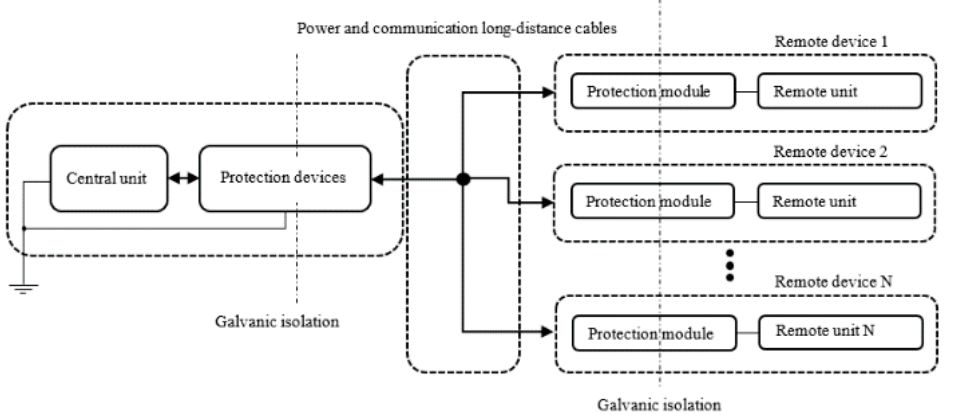
Figure 1. General diagram of a typical railway application.